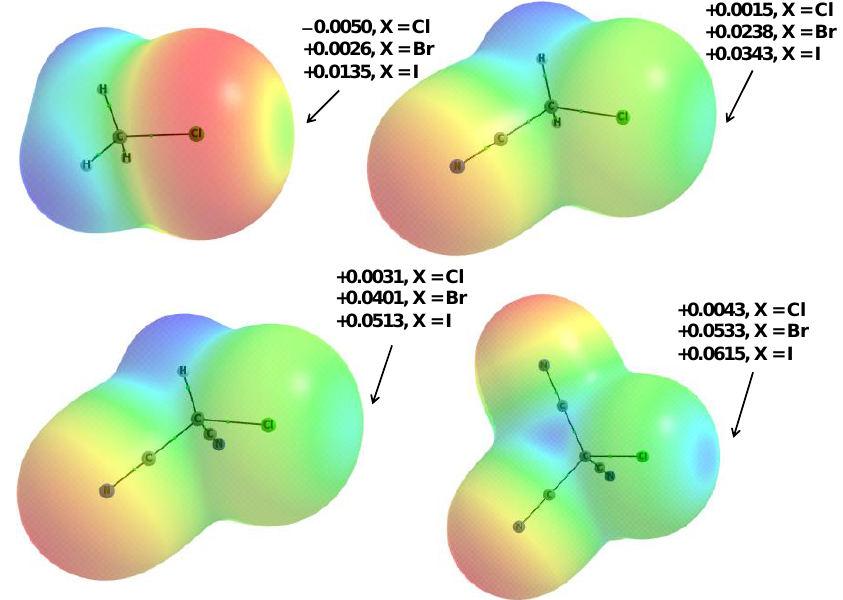
Figure 9. The EP surfaces of the CH n-3 (CN) n Cl monomers. The EP maxima on the halogen σ -holes are listed (in au) for X = Cl, Br, I. The number of CN groups increases from 0 to 3.